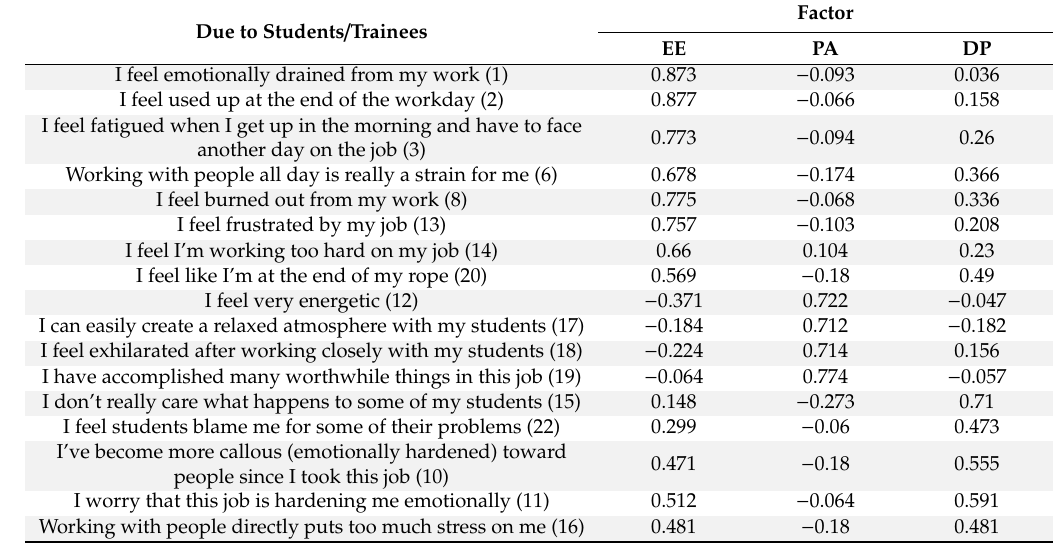
Table A1. Rotated factor Matrix for Burnout due to Student’s Interaction.